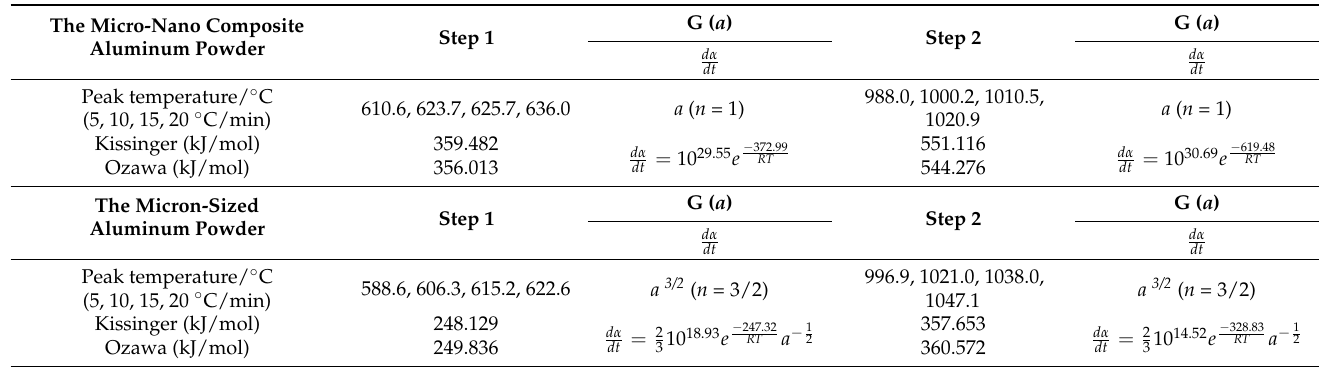
Table 1. The calculation result of the activation energy of the two-step oxidation reaction.